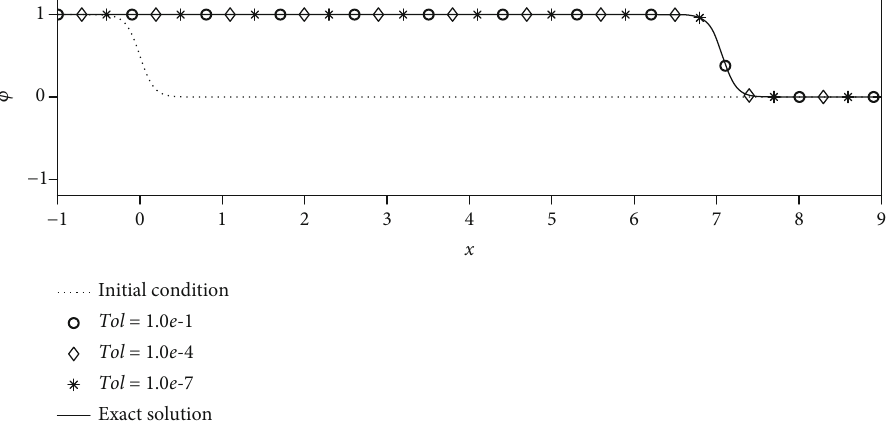
Figure 5: Initial condition (dotted line); and the numerical results with tol = 1 : 0 e - 1 , 1 : 0 e - 4 , and 1 : 0 e - 7 with the exact solution (solid line) at time t = 0 : 2 .